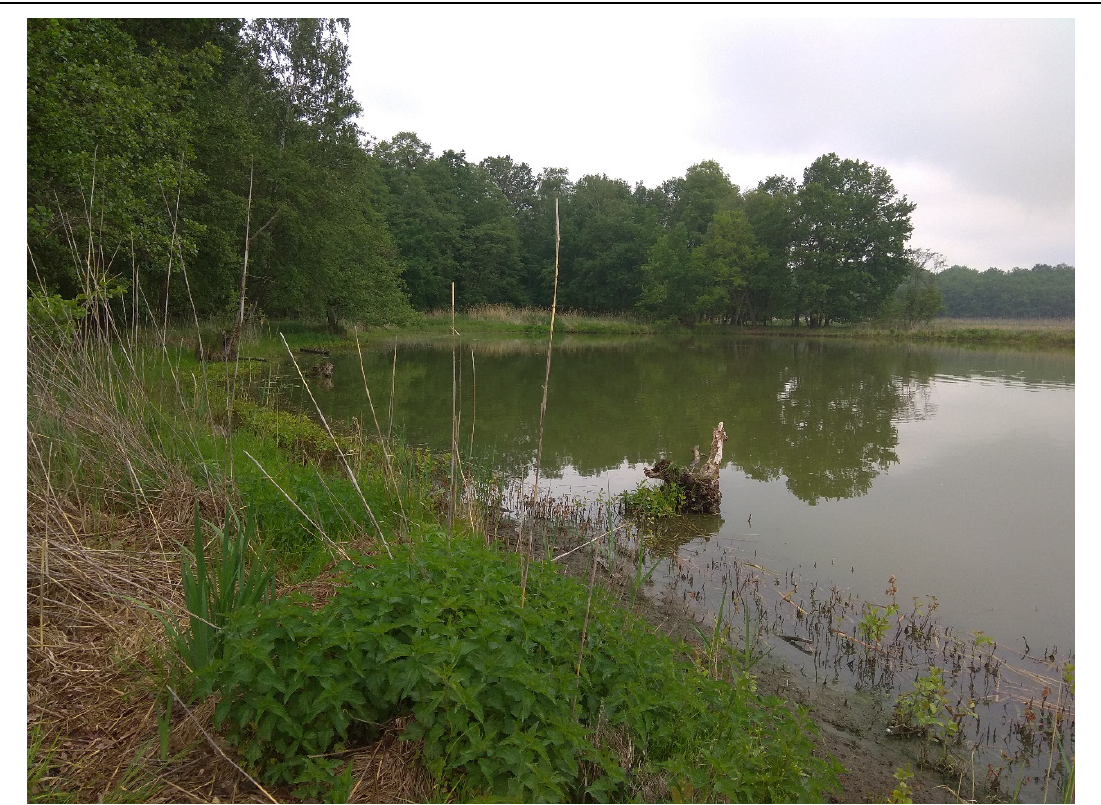
Figure 3. An image of the area of interest from May